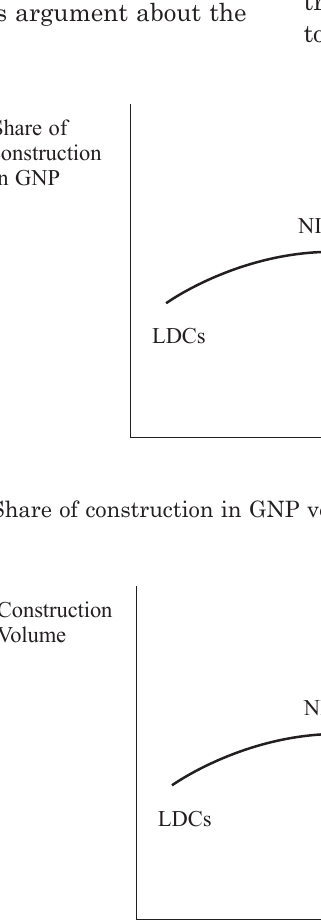
figure 2. Construction volume over time (Bon, 1992)